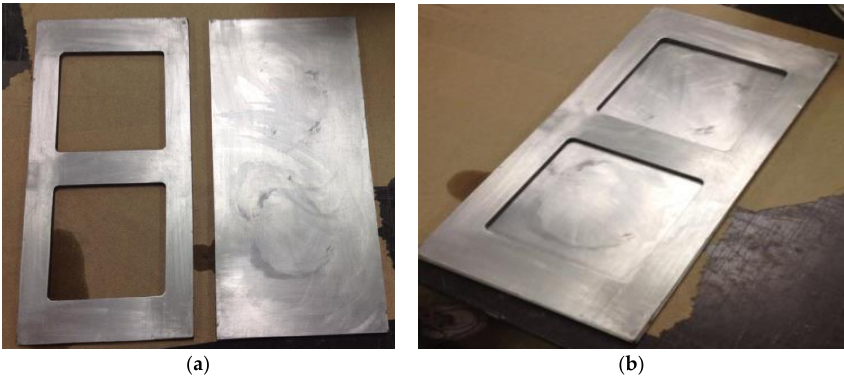
Figure 4. ( a ) Two-separate piece mold made of stainless steel; ( b ) Combined molds one serves as a